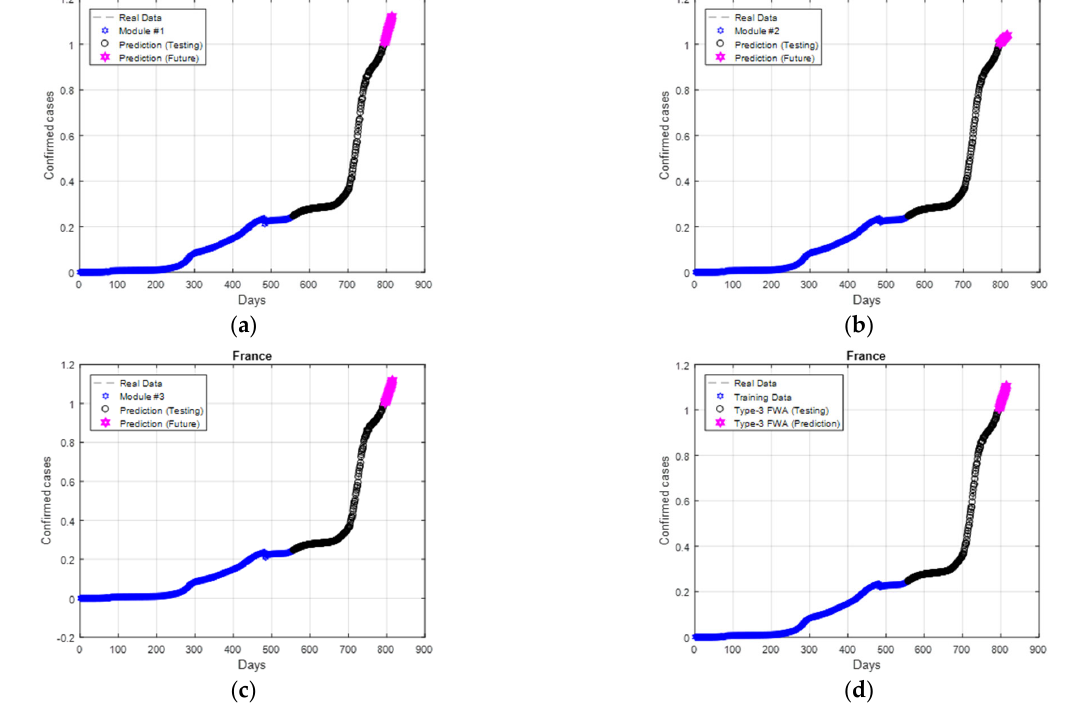
Figure 21. Individual behavior and final prediction for France: ( a ) module #1; ( b ) module #2; ( c ) module #3; ( d ) final prediction.